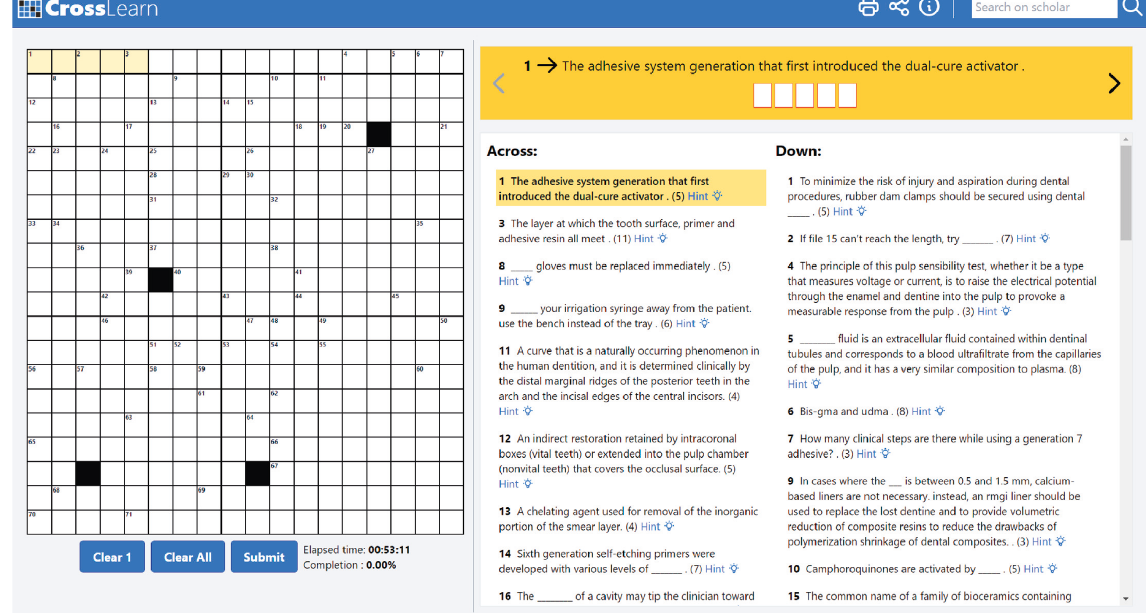
Figure 1: Interactive crossword puzzle design. The puzzles consist of horizontal and vertical columns, with the words running horizontally from left to right and vertically from top to bottom.